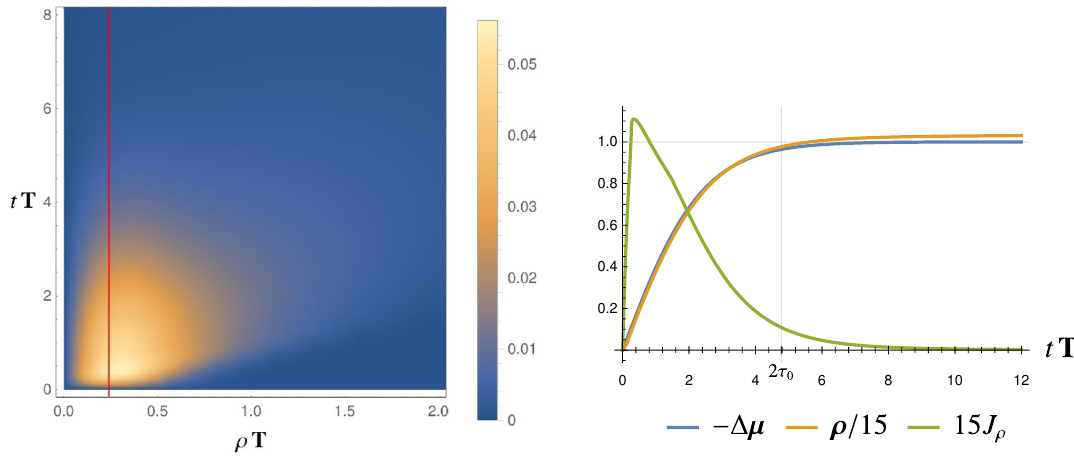
Figure 2 . Slow quench (cid:28) 0 = 10 z h (cid:25) 2 : 4 T (cid:0) 1 . Left: the pro(cid:12)le of the radial current depending on time t . No propagating waves are seen. Right: the time-dependence of the local chemical potential and charge density at (cid:26) = 0 and the current density at (cid:26) (cid:24) (cid:26) 0 (cid:25) 0 : 25 T (cid:0) 1 (characteristic radius of the initial quench, shown by red gridline on the